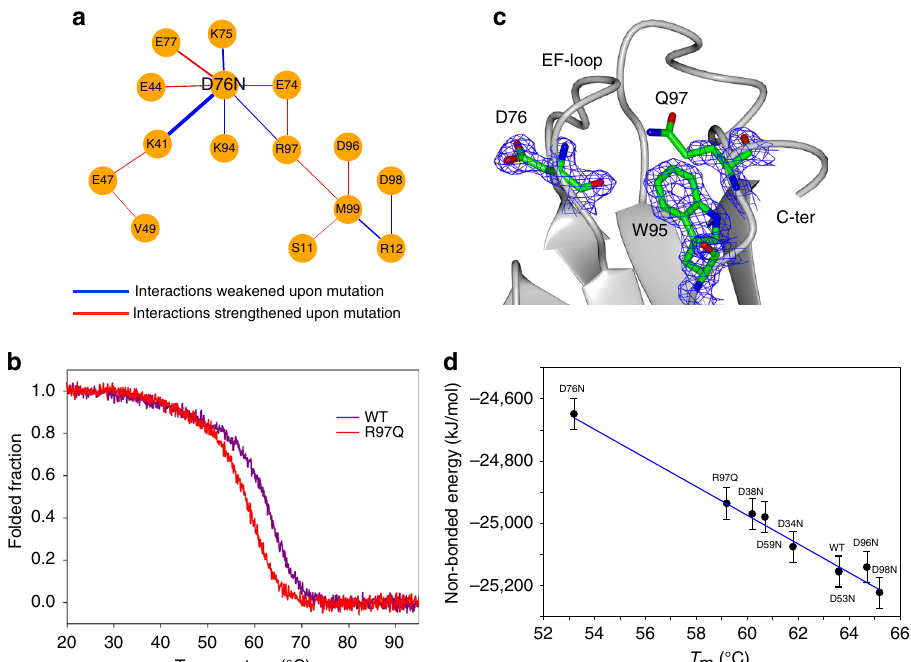
Fig. 5 Perturbation of the energy network upon D76N mutation. a The network shows the interactions between couples of amino acids that are strengthened (red) or weakened (blue) upon mutation as calculated over the two ensembles of structures. b Temperature ramp of wt and R97Q variants monitored by far-UV ( T m : WT = 63.6 °C, R97Q = 59.2 °C). c Crystal structure of the R97Q mutant. Electron density (2FoFc) at 1.2 σ is clipped around residue D76, W95, and Q97 shown as cylinder models. The lack of electron density for Q97 side chain indicates its high fl exibility. d Correlation between thermal stabilities for multiple β 2m variants and the predicted change in energy obtained from the wild type ensembles by removing (or inverting) the side chain charges. Error bars (s.e.m.) where obtained through a block-averaging